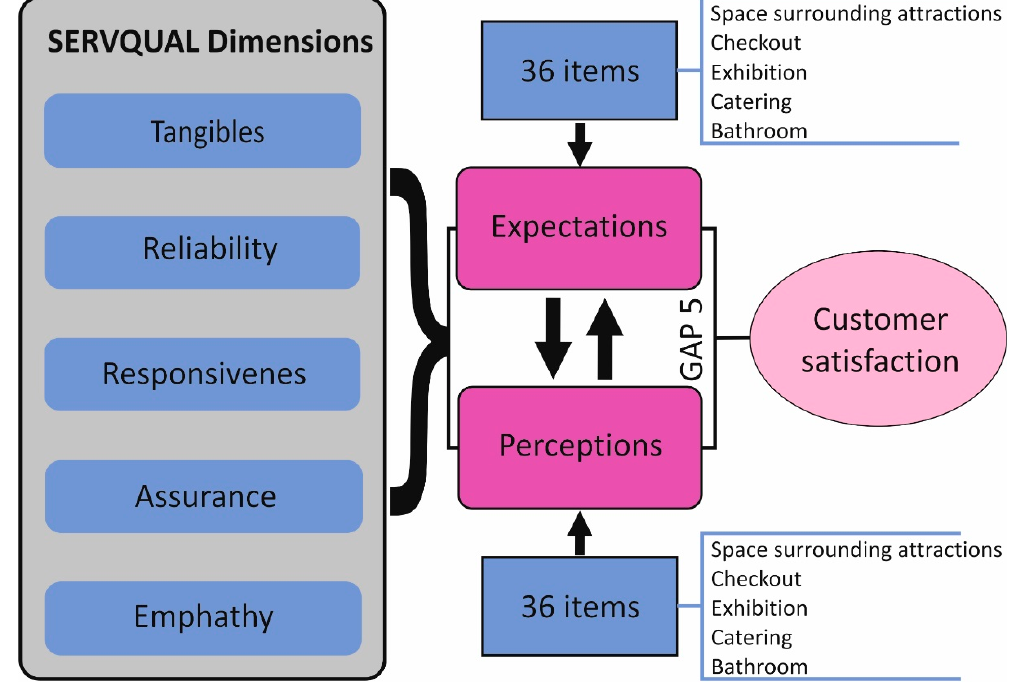
Figure 5. The main elements of the methodological approach used in the presented research (source: own study).